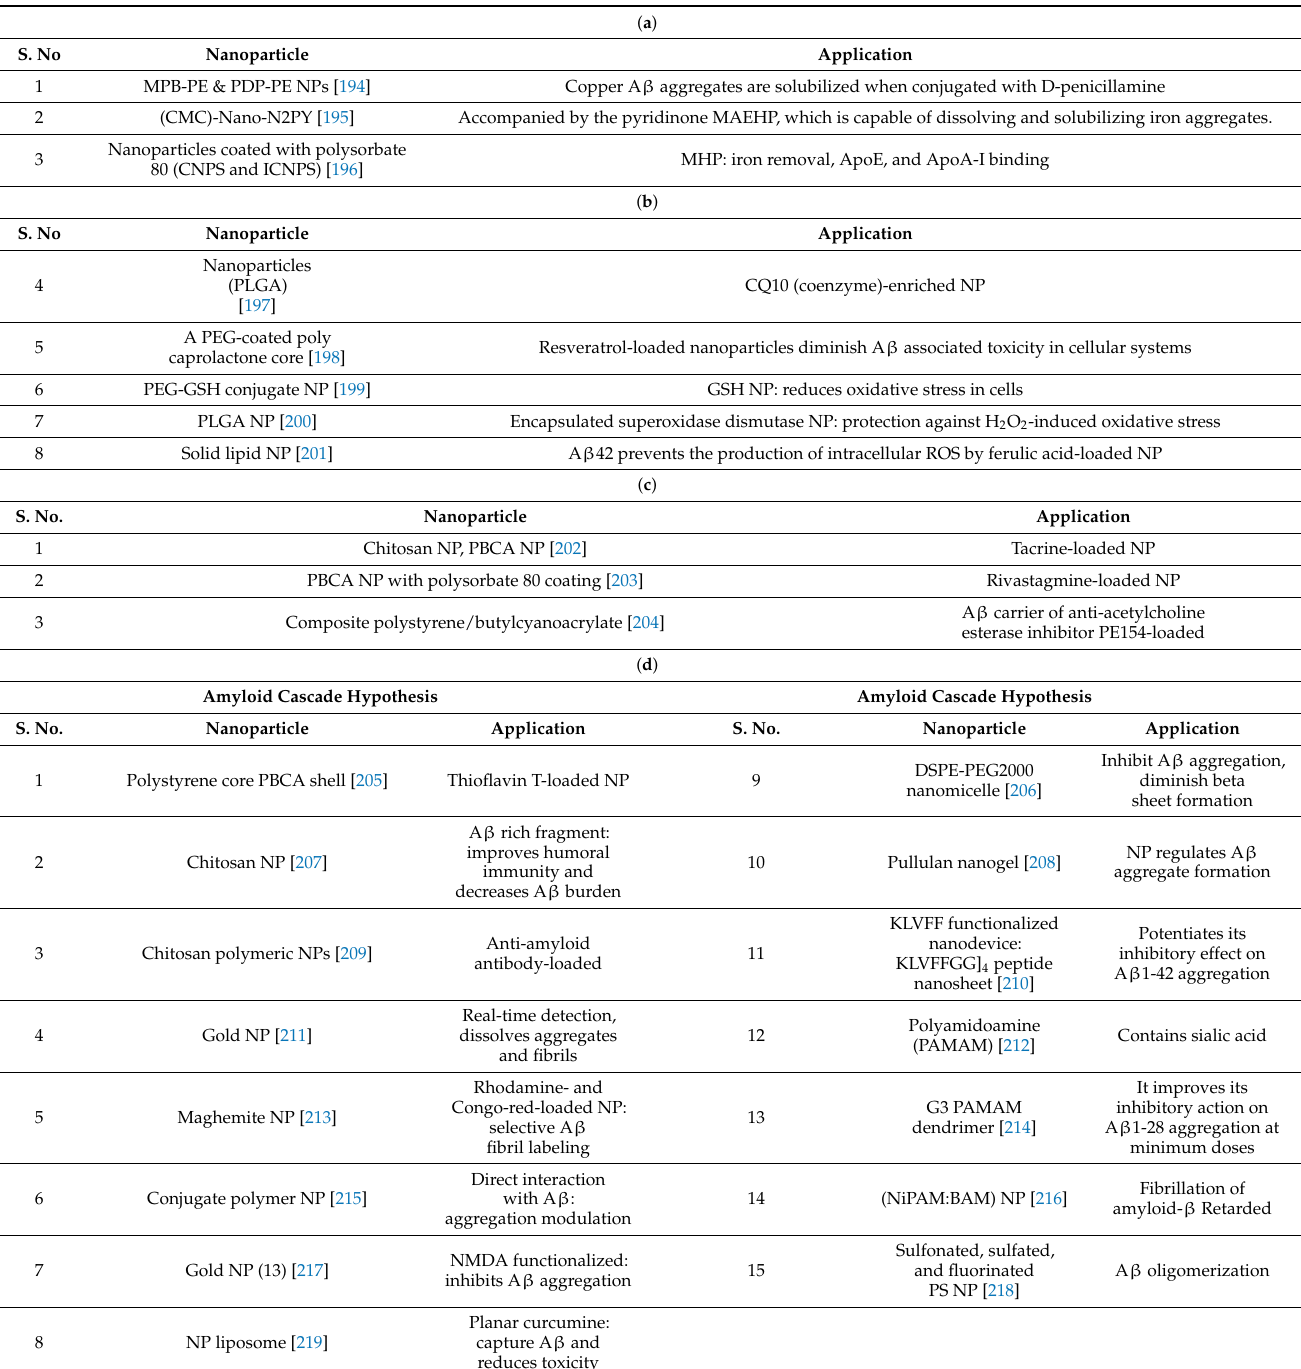
Table 3. Nanoparticles (NPs) developed for the diagnosis and treatment of Alzheimer’s disease: Classified on various hypothesis. ( a ) Amyloid cascade hypothesis and metal chelation therapy, ( b ) Oxidative stress, ( c ) Cholinesterase inhibitor, ( d ) Amyloid cascade hypothesis. ( a